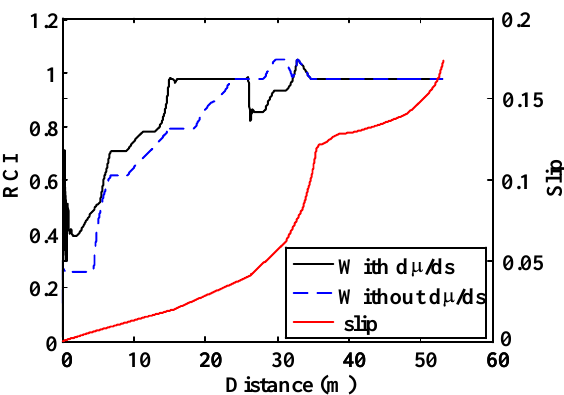
Figure 17. Straight line simulation. Surface µ = 1. Road condition fuzzy block outputs comparative.